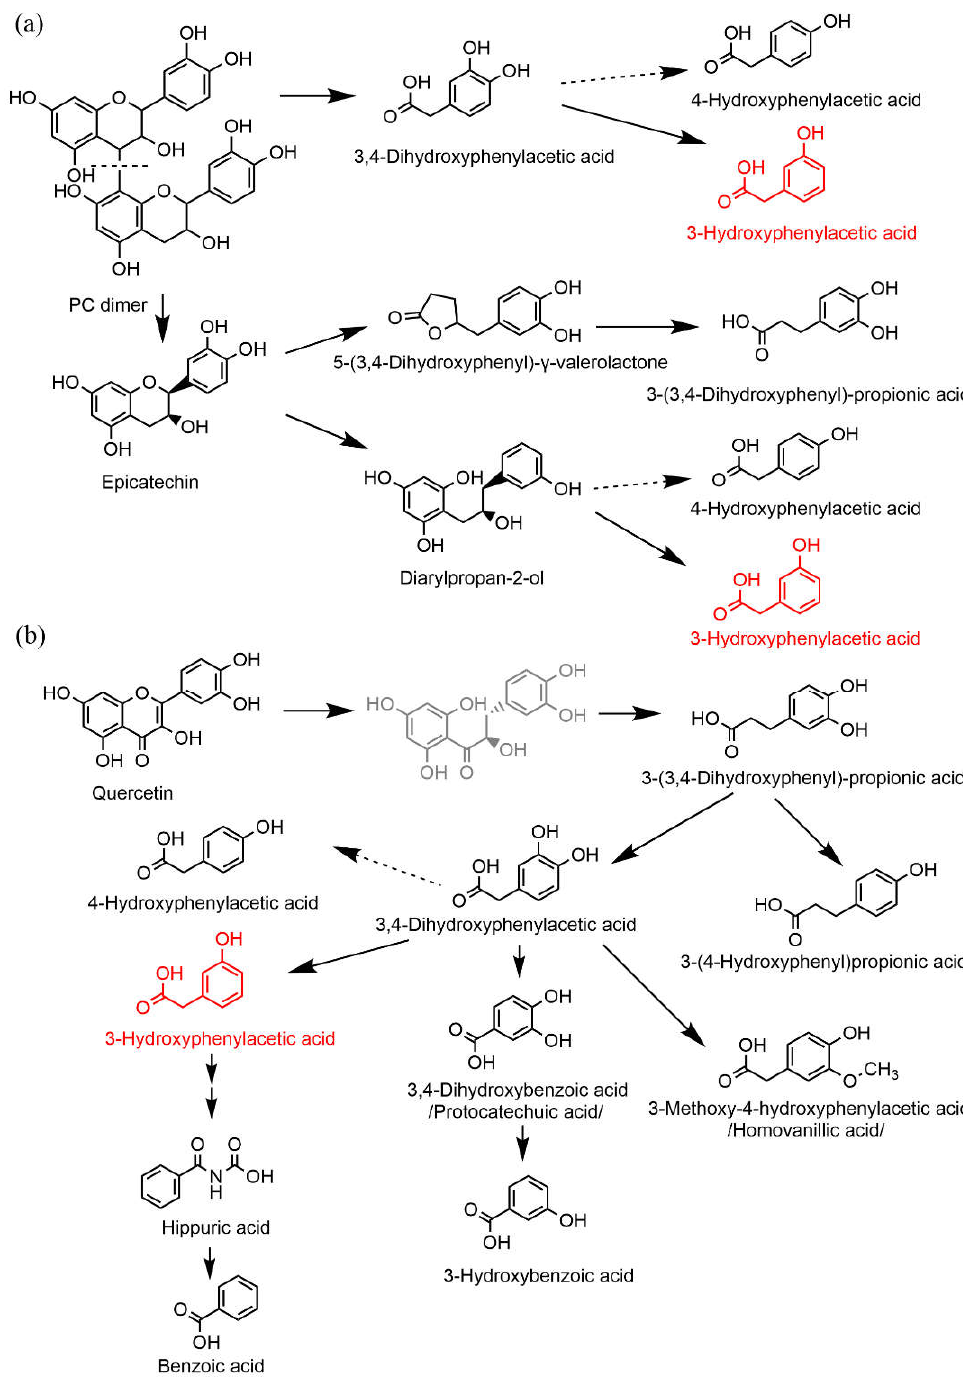
Figure 1. Simplified schemes of proposed pathways for microbial degradation of different flavonoids in humans: flavanols ( a ) and flavonol quercetin ( b ). PC: procyanidin. 3-hydroxyphenylacetic acid (3-HPAA) is depicted in red; the structures in black are metabolites that were detected, whereas structures in grey represent hypothetical intermediates. Data were obtained from the following references: [16,17,20–23].